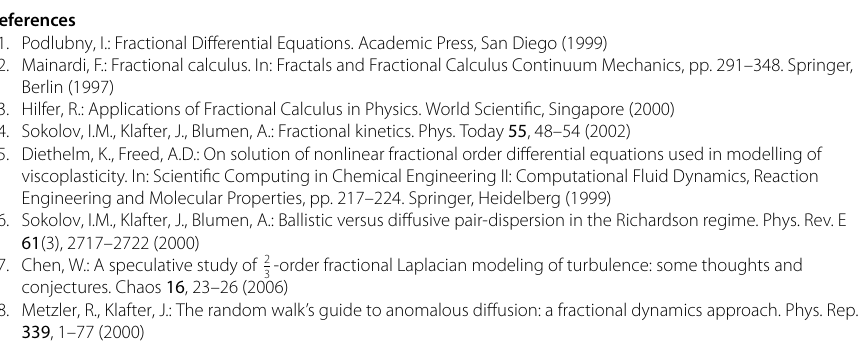
Table 8 The maximum errors when τ = h = 1 γ IDAS [23] Present Method CPU Time (s) 0.4 0.1792436e–02 0.156